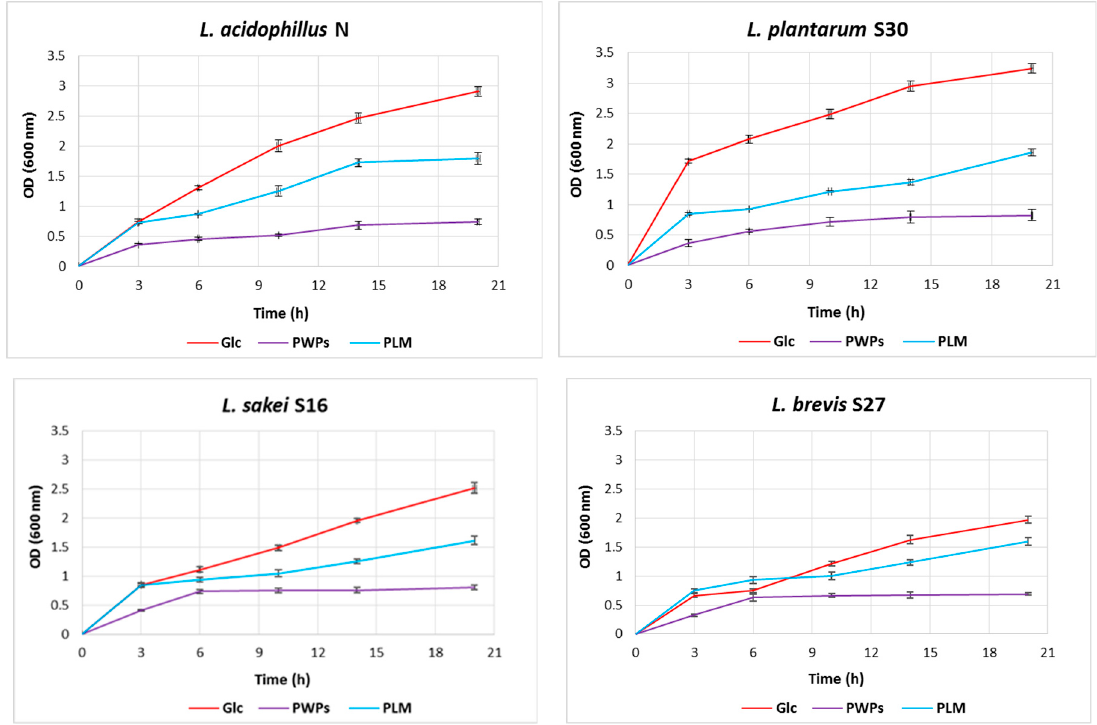
Figure 4. Optical density value (OD) of L. acidophilus N, L. plantarum S30, L. sakei S16 and L. brevis S27 strains in the presence of glucose (Glc), PWPs and PLM. All analyses were conducted in triplicate, and data are expressed as mean values ± SD. Three-way ANOVA test: Sig. ( p < 0.05), partial eta 2 (0.822–0.998), R 2 = 0.997 (R 2Adj. = 0.996).